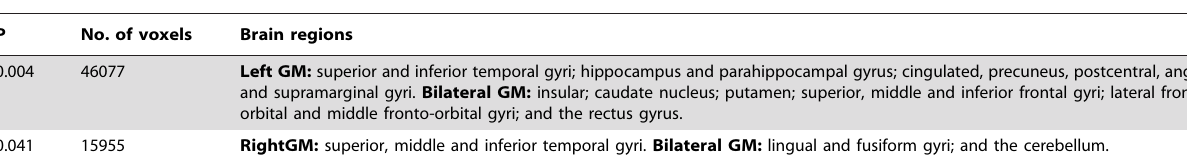
Table 3. Brain regions with negative correlation between grey matter volume and the number of optic neuritis attacks.